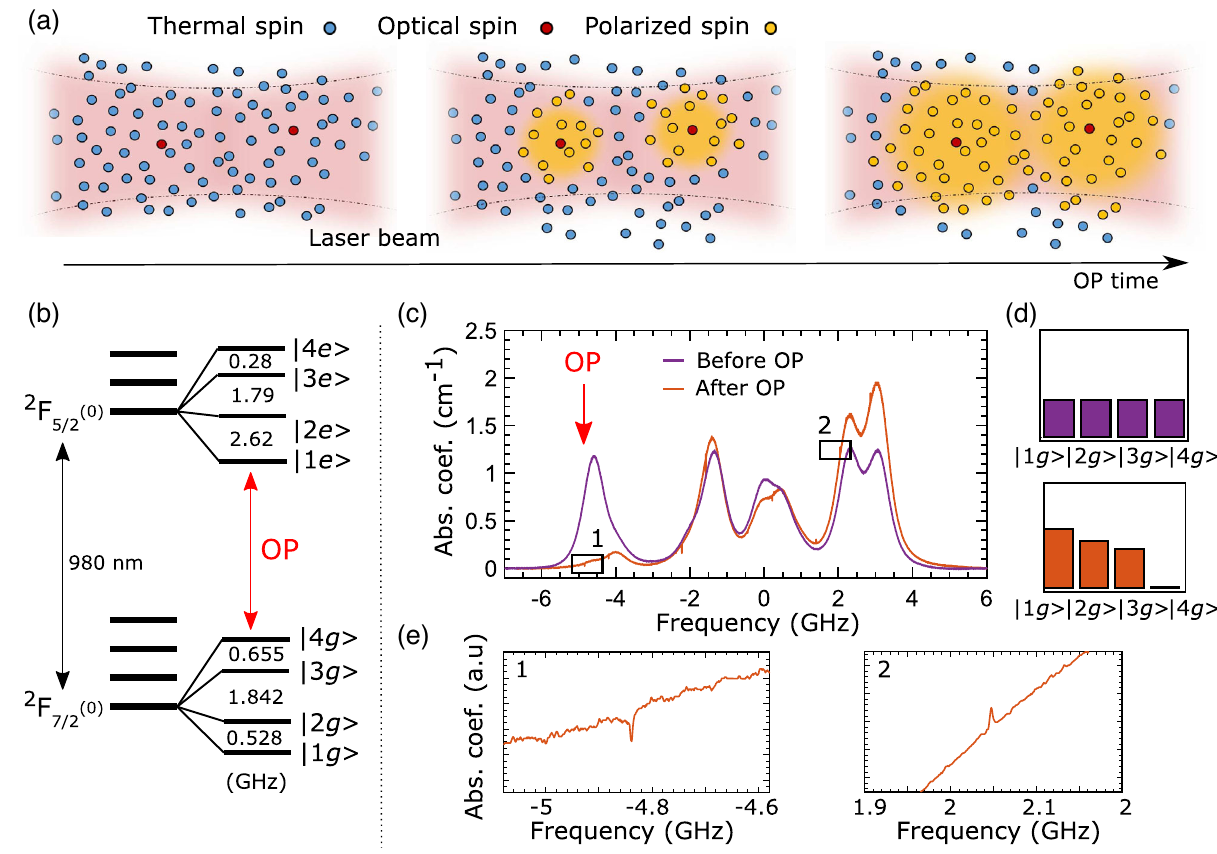
FIG. 1. Diffusion enhanced optical pumping (DEOP) in 171 Yb 3 þ ∶ Y 2 SiO 5 . (a) DEOP mechanism: Optically pumped spins (red circles) initially surrounded by spins in thermal equilibrium (blue circles) gradually polarize neighboring spins and spins that are further apart (yellow circles) through flip-flop interactions. (b) Energy diagram showing the 171 Yb 3 þ hyperfine structure. (c) Absorption spectrum without (purple) and after 20 s of optical pumping (orange). The OP is along the j 4 g i → j 1 e i transition [red arrow in panels (b) and (c)]. (d) Ground-state spin populations k , normalized by thermal equilibrium values, over the volume ig ¼ 1 ) and after OP (bottom, orange, k ¼ 1 . 67 (cid:2) 0 . 30 , 1 . 28 (cid:2) 0 . 36 , addressed by the laser without OP (top, purple, k 1 g , k 2 g , k 3 g , k 4 g ig 1 . 01 (cid:2) 0 . 12 , 0 . 04 (cid:2) 0 . 04 ). (e) Enlarged regions 1 and 2 in panel (c) showing a narrow hole at the laser frequency ( j 4 g i → j 1 e i ) and a corresponding antihole ( j 2 g i → j 3 e i